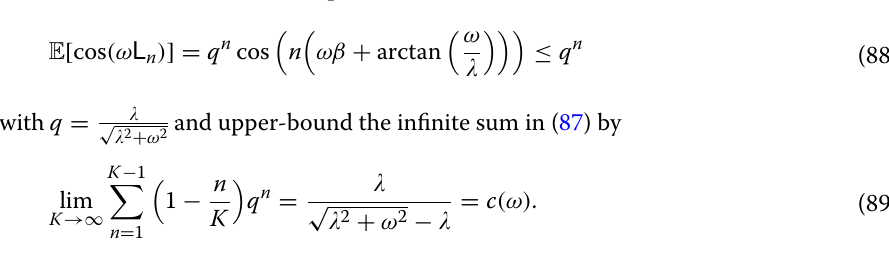
n T k T v A k i is the corresponding random variable. As i 1 = − = + = (cid:31)